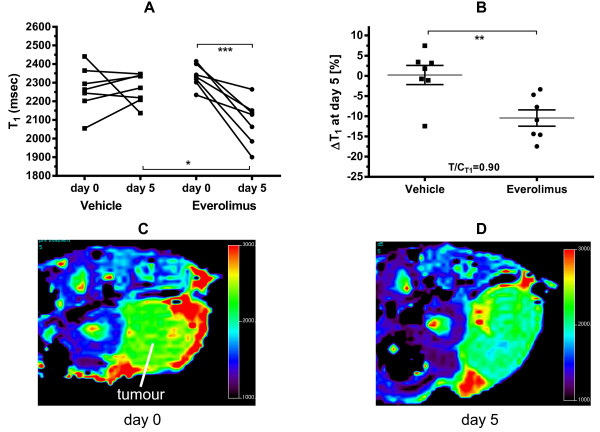
Everolimus decreases the T1 of RIF-1 tumours. C3H mice bearing RIF-1 tumours were treated with everolimus (10 mg/kg/day) or vehicle for 5 days and the spin–lattice relaxation of protons (T1) in tumours was measured on day 0 and at the endpoint day 5. Results show the individual values for each tumour, n = 7 per treatment group (A) and the mean ± SEM fractional change ΔT1 for each treatment (B), where *p < 0.05, **p < 0.01, ***p < 0.001 as shown. Panel C &D show an MRI-derived T1 map from a representative RIF-1 tumour (arrow) before (C) and after (D) treatment with everolimus.